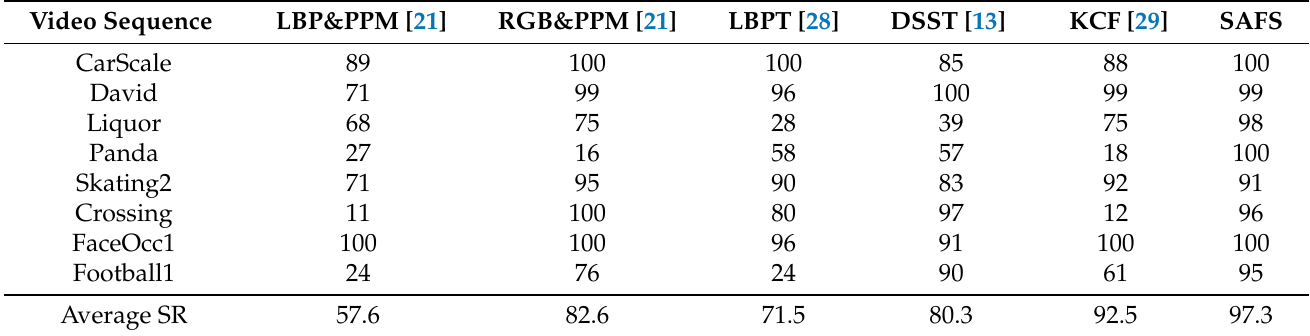
Table 2. The SR (%) of the SAFS method compared with other five methods.